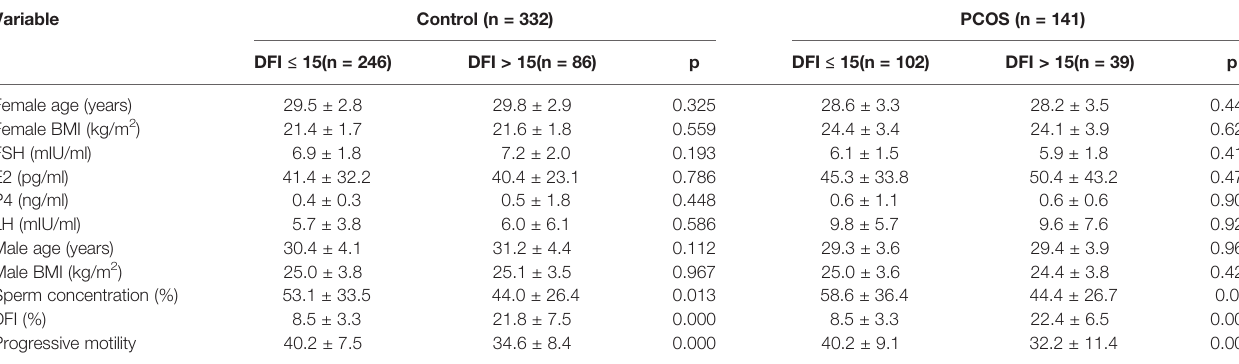
TABLE 1 | The basic clinical characteristics in control and PCOS patients with different sperm DFI.